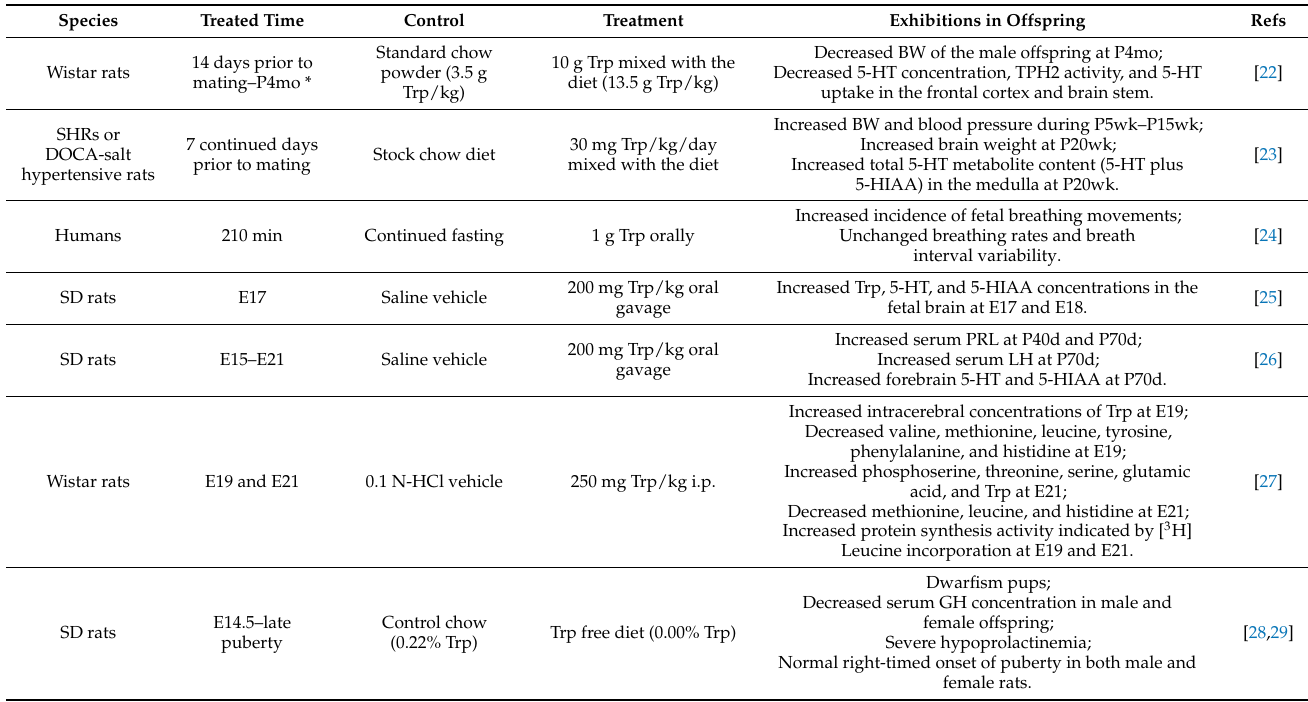
Table 1. Non-comprehensive review of the effects of maternal Trp administration on the physiological and behavioral exhibitions in